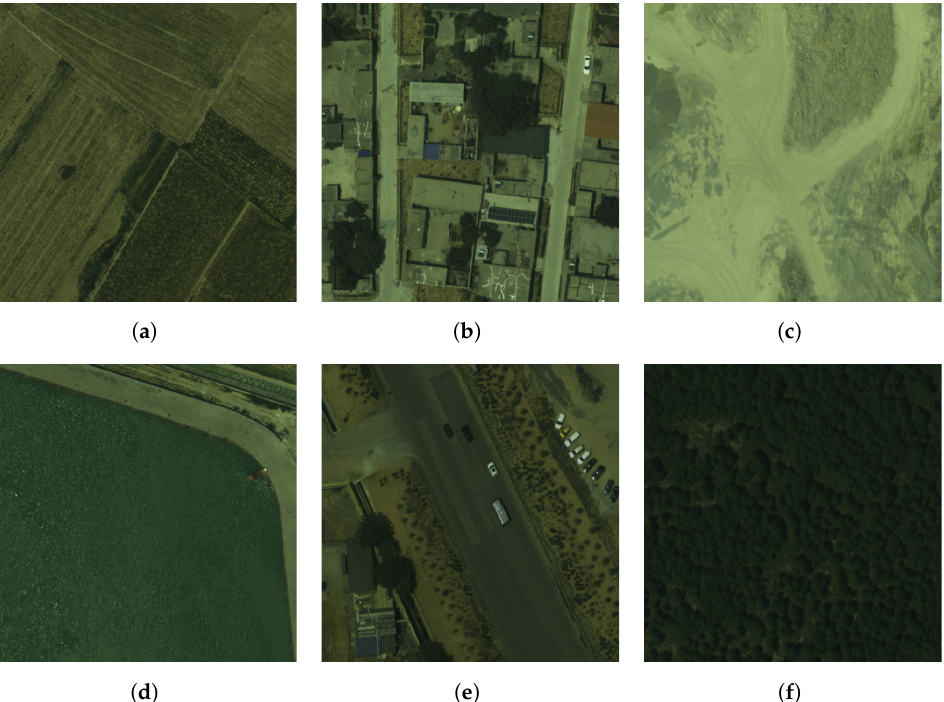
Figure 4. Shandong Feicheng Denoising (SFD) dataset: ( a ) farmland; ( b ) building; ( c ) dirt; ( d ) lake; ( e ) road; and ( f )